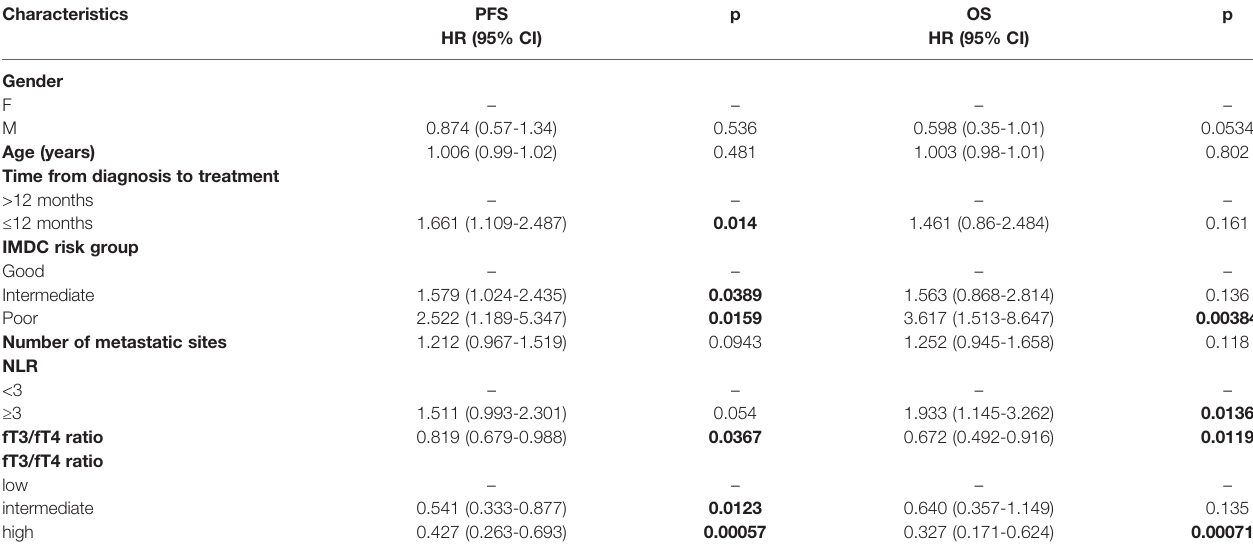
TABLE 2 | Univariate analysis of characteristics associated with PFS and OS.